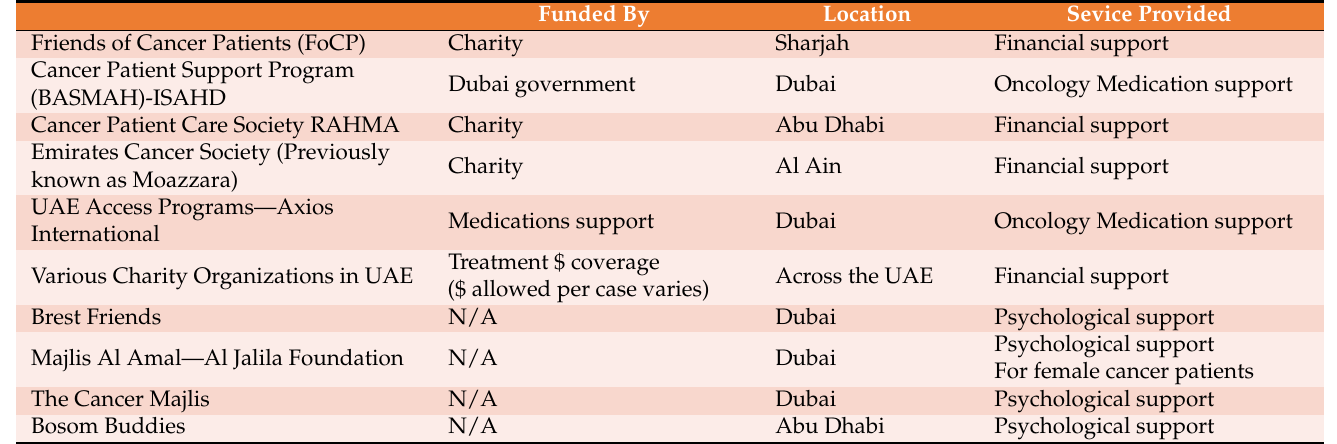
Table 8. Cancer support programs and cancer support groups in the